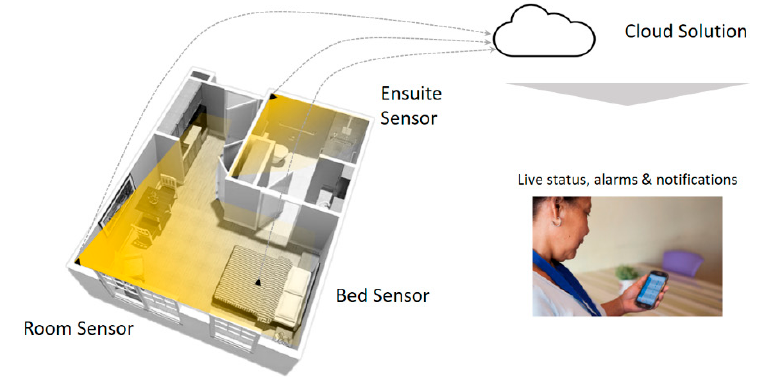
Figure 8. Overview of sensor